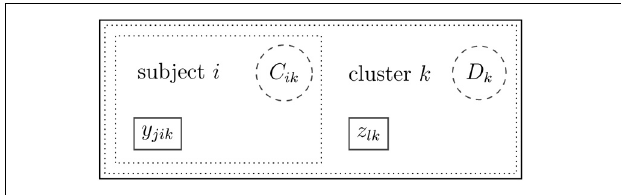
FIGURE 1 | Observed variable scores y jik (within-level) and z lk (between-level) as well as mixtures C ik (within-level) and D k